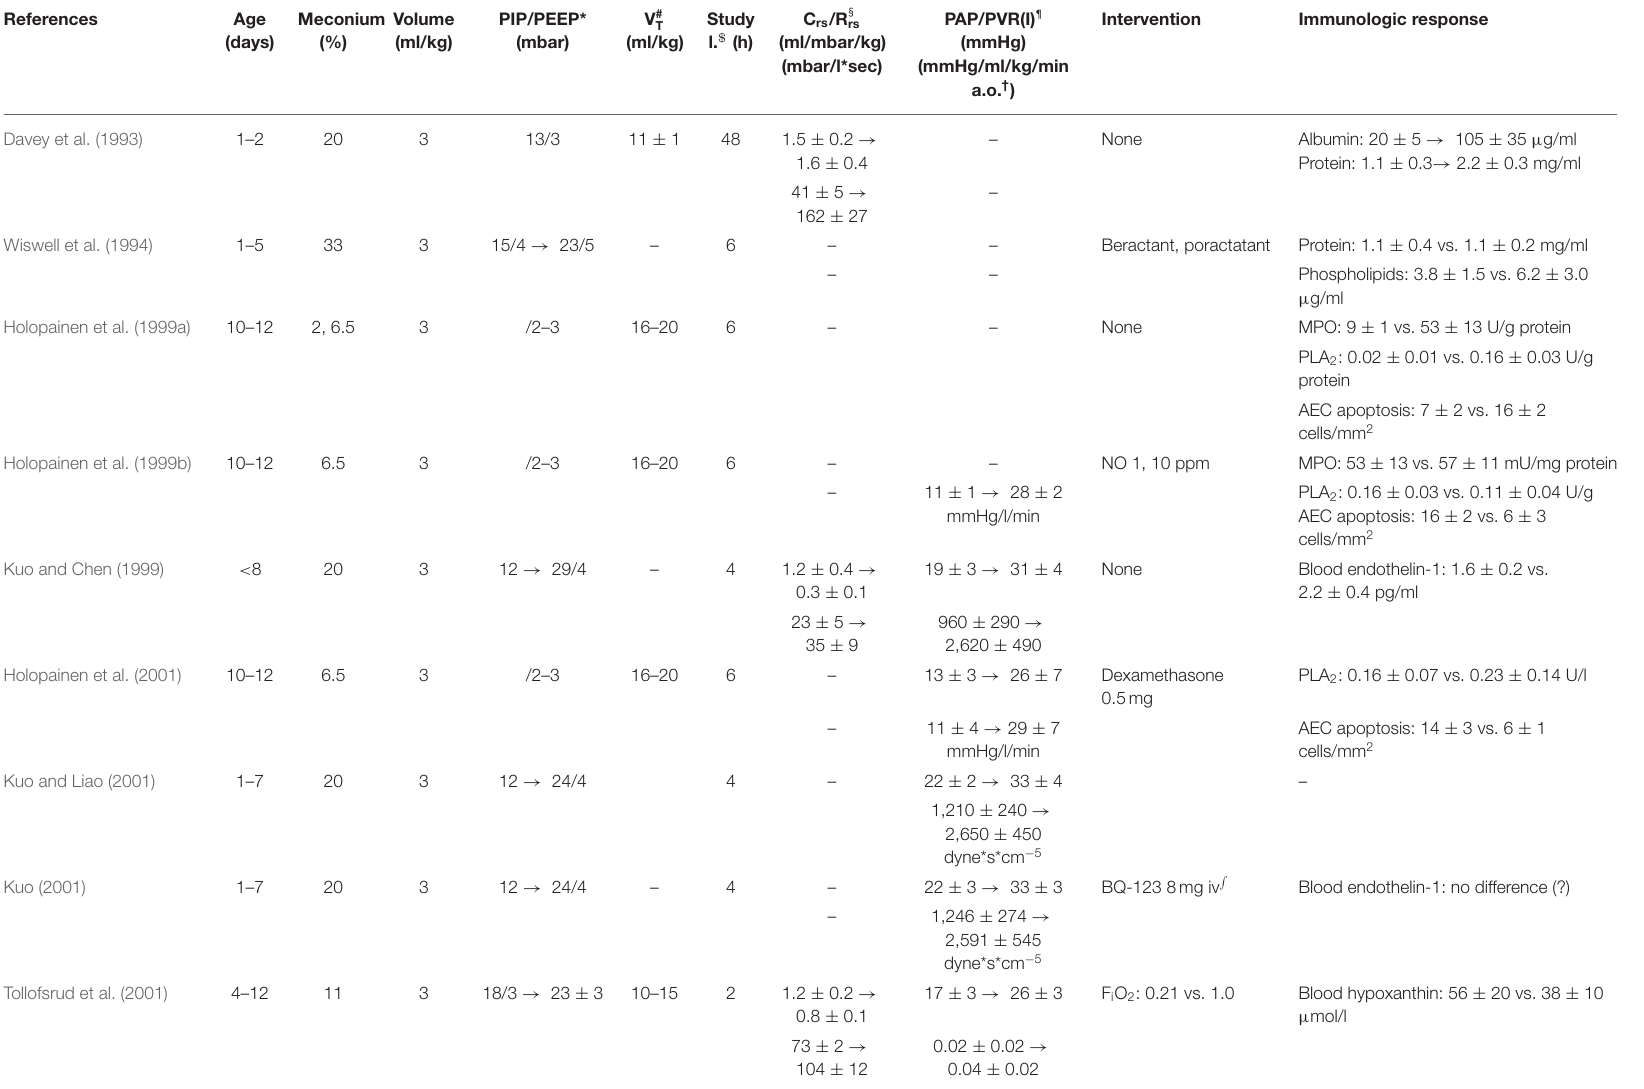
TABLE 11 | Meconium aspiration